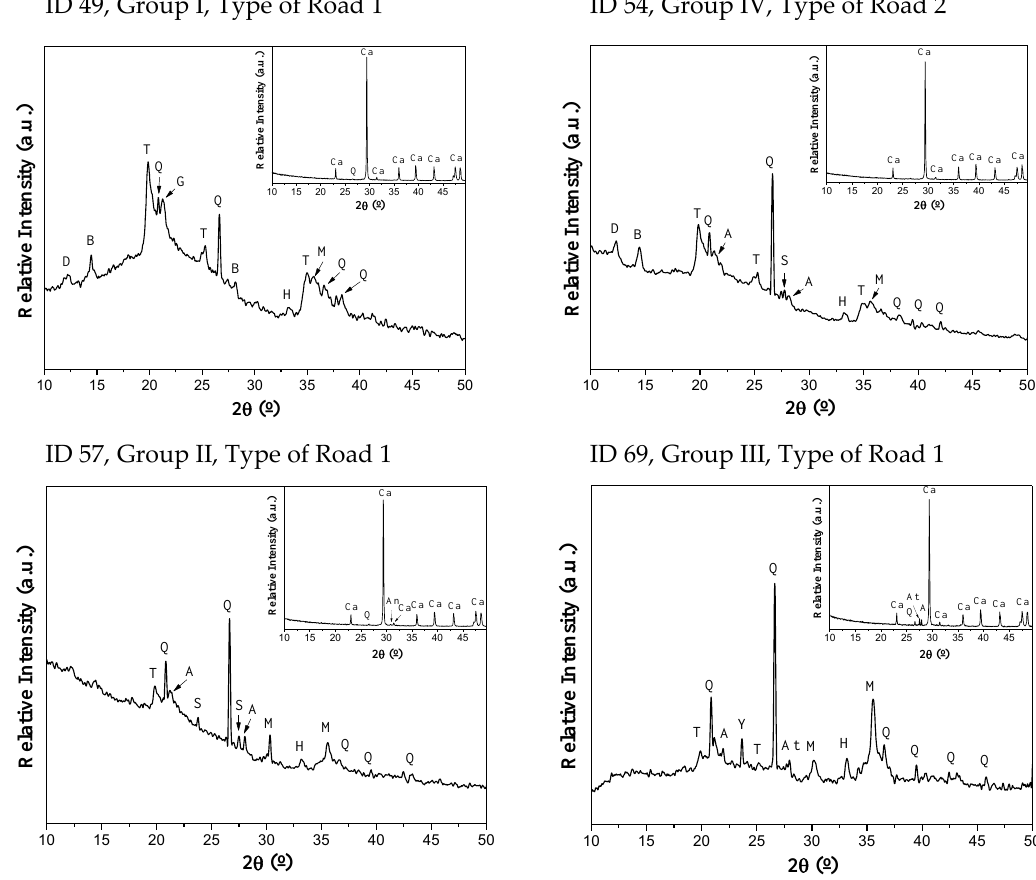
Figure 6. Major minerals in road dust with calcite and without calcite. A = albite, An = ankerite, At = anorthoclase, B = boehmite, Ca = calcite, D = dickite, G = goethite, H = hematite, M = maghemite, Q = quartz, S = sanidine, T = tosudite, Y = yeelimite.